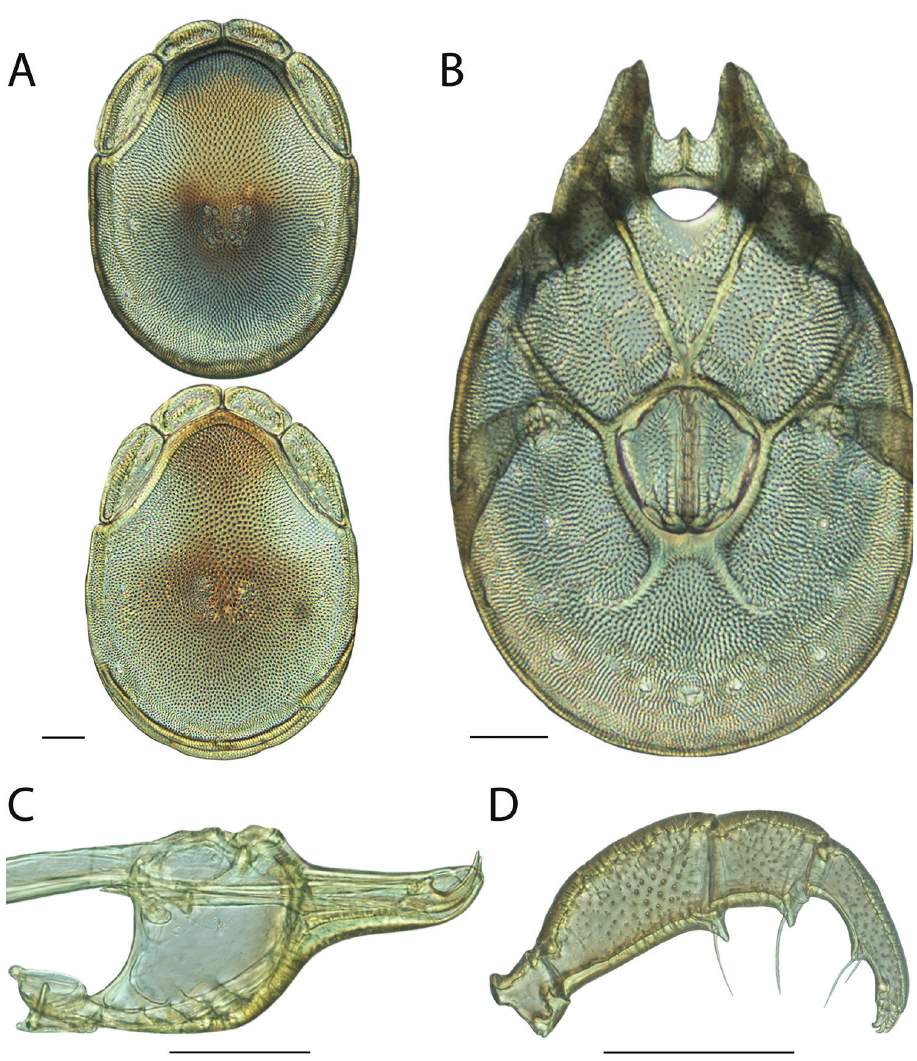
Figure 268. Torrenticola ventura female: A dorsal plates, note color variation B venter (legs removed) C subcapitulum D pedipalp (setae not accurately depicted). Scale = 100